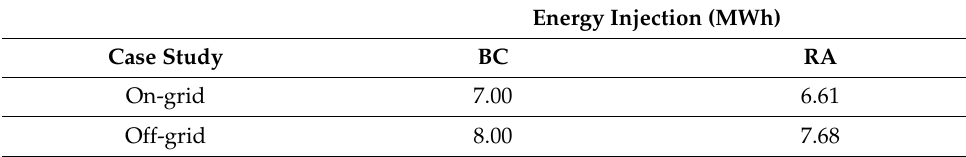
Table 3. Total energy outputs of DGs for different operation modes of